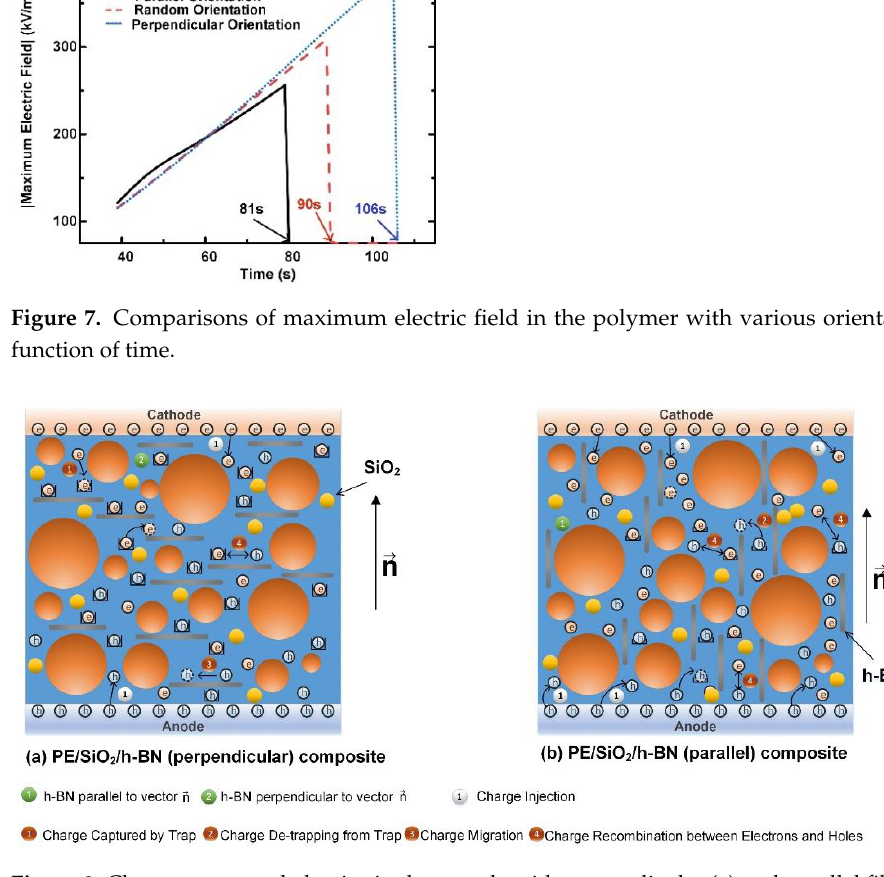
Figure 8. Charge transport behavior in the sample with perpendicular ( a ) and parallel filler orientation ( b ).